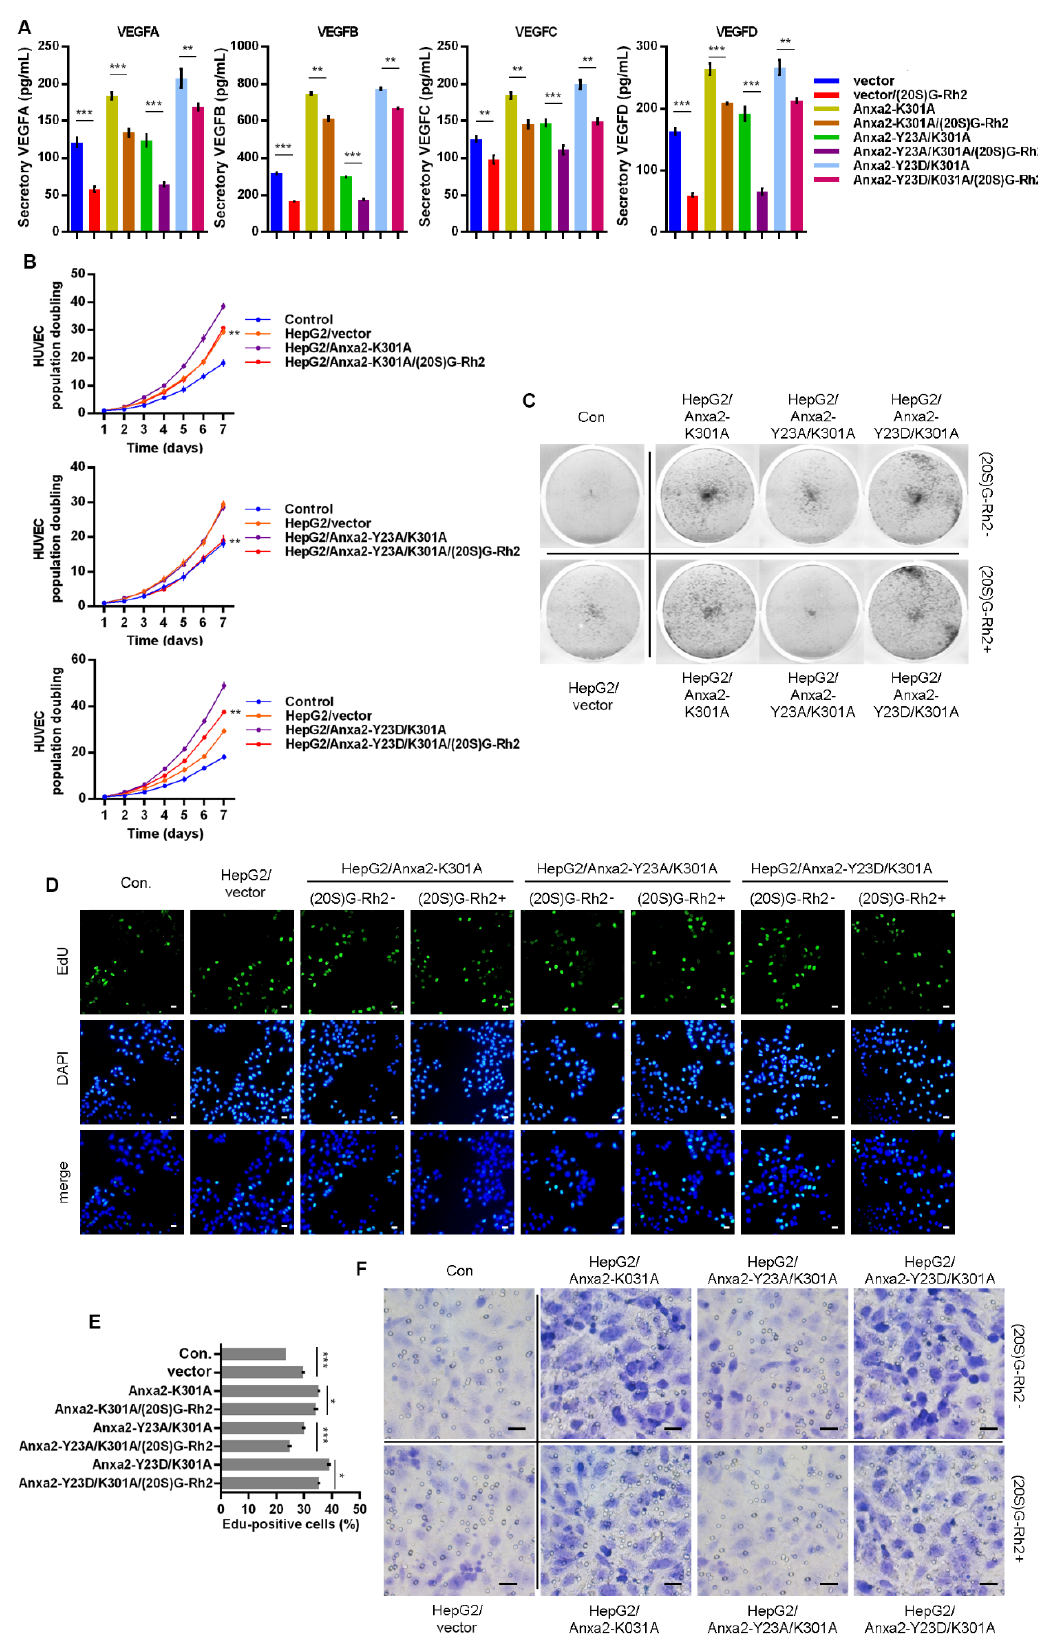
Figure 8. Anxa2-K301A mutant maintained pro-proliferation and pro-migration capability of HepG2 cells under (20S)G-Rh2 treatment. Myc-tagged K301A, Y23A/K301A mutant and Y23D/K301A mutant of Anxa2 was over-expressed in